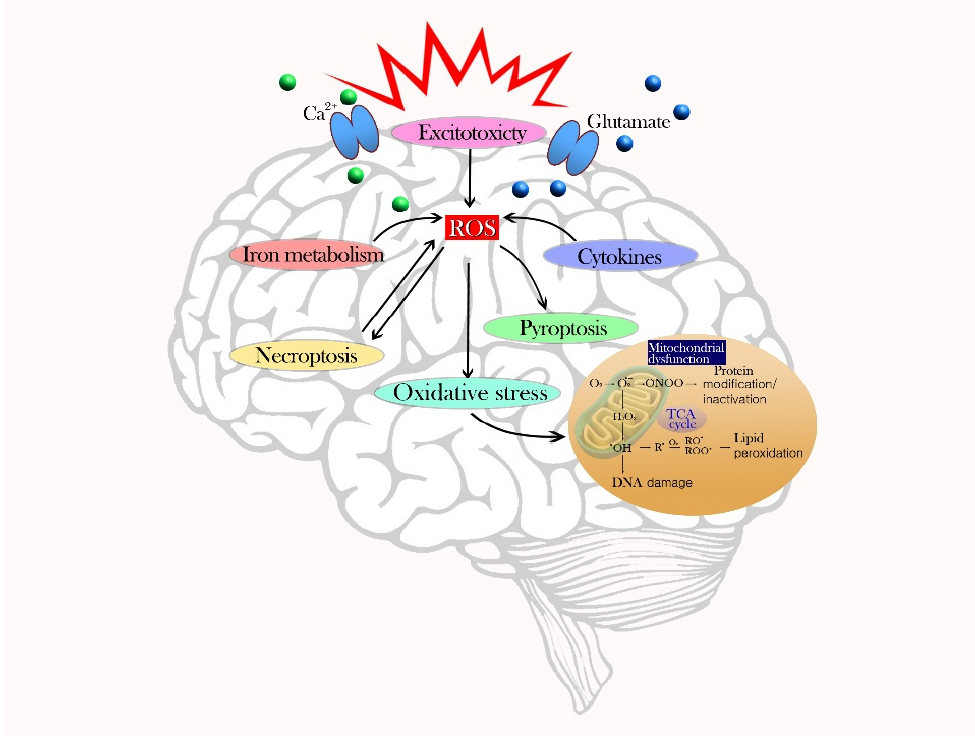
Figure 1. Schematic of the main pathophysiological mechanism of cell death due to oxidative stress. The presence of ROS due to an imbalance of pro-oxidants and antioxidants can damage a variety of cells in the brain. Formation of ROS and mitochondria dysfunction occurs during the primary mechanism of oxidative stress. Secondary mechanisms of cell death by ROS production include excitotoxicity, iron metabolism, cytokines, pyroptosis, and necroptosis, which amplify cell death.